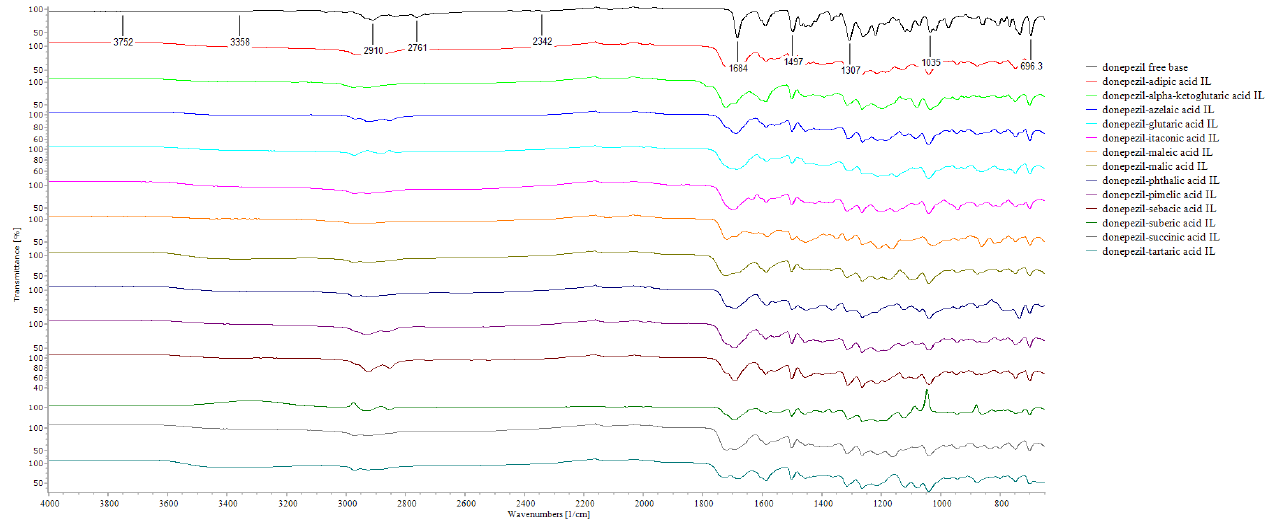
Figure 5. FT-IR spectra of DPZ and DPZ ILs.